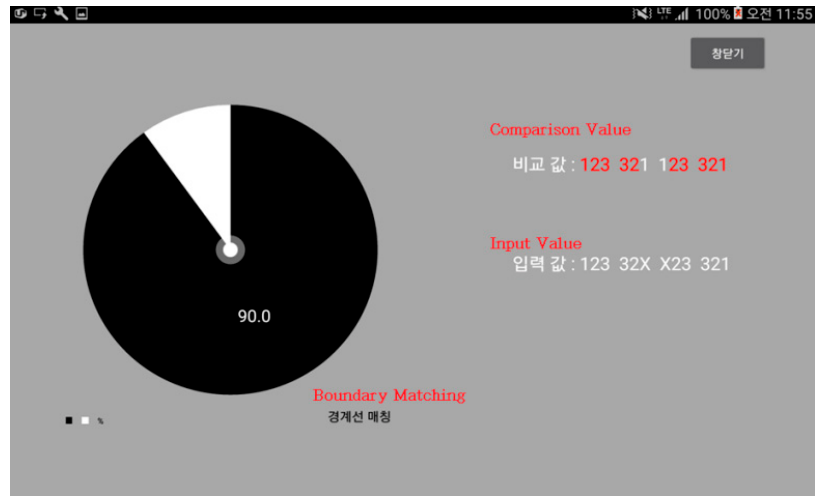
Figure 13. Result of Boundary Matching.